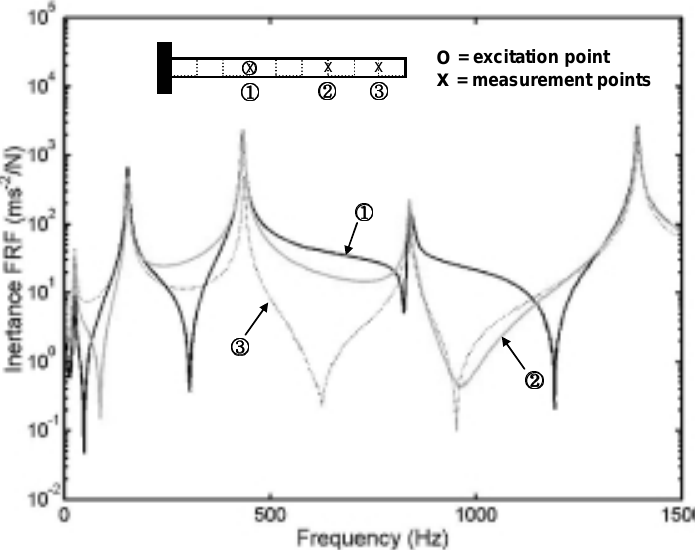
Fig. 7. The inertance FRF curves measured at x = 0 . 133 m (point 1), 0.267 m (point 2), and 0.356 m (point 3) of the damaged